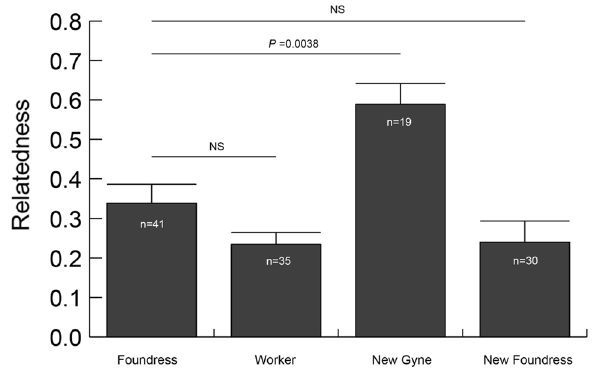
Figure 4. Genetic relatedness among each class of females: foundresses, workers, new gynes, and new foundresses (i.e., foundresses observed the following spring). Welch’s t-test indicated that values among foundresses differed significantly from those among new gynes, even after sequential Bonferroni correction. Sample sizes indicate the number of colonies used to calculate genetic relatedness. NS nonsignificant (Welch’s t-test) after sequential Bonferroni correction.